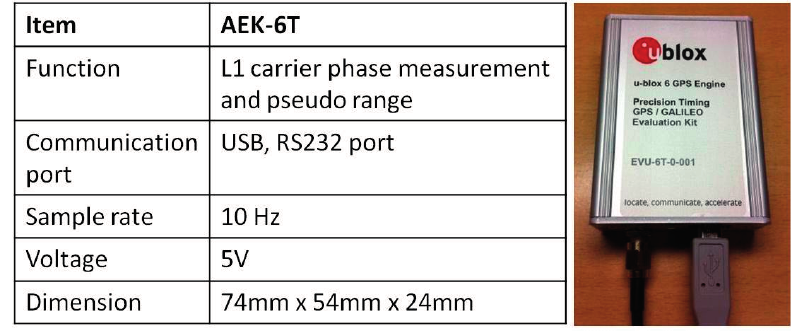
Figure 8. The GPS receiver of DG module.